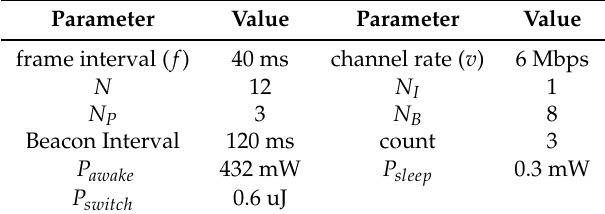
Table 1. Simulation parameters.